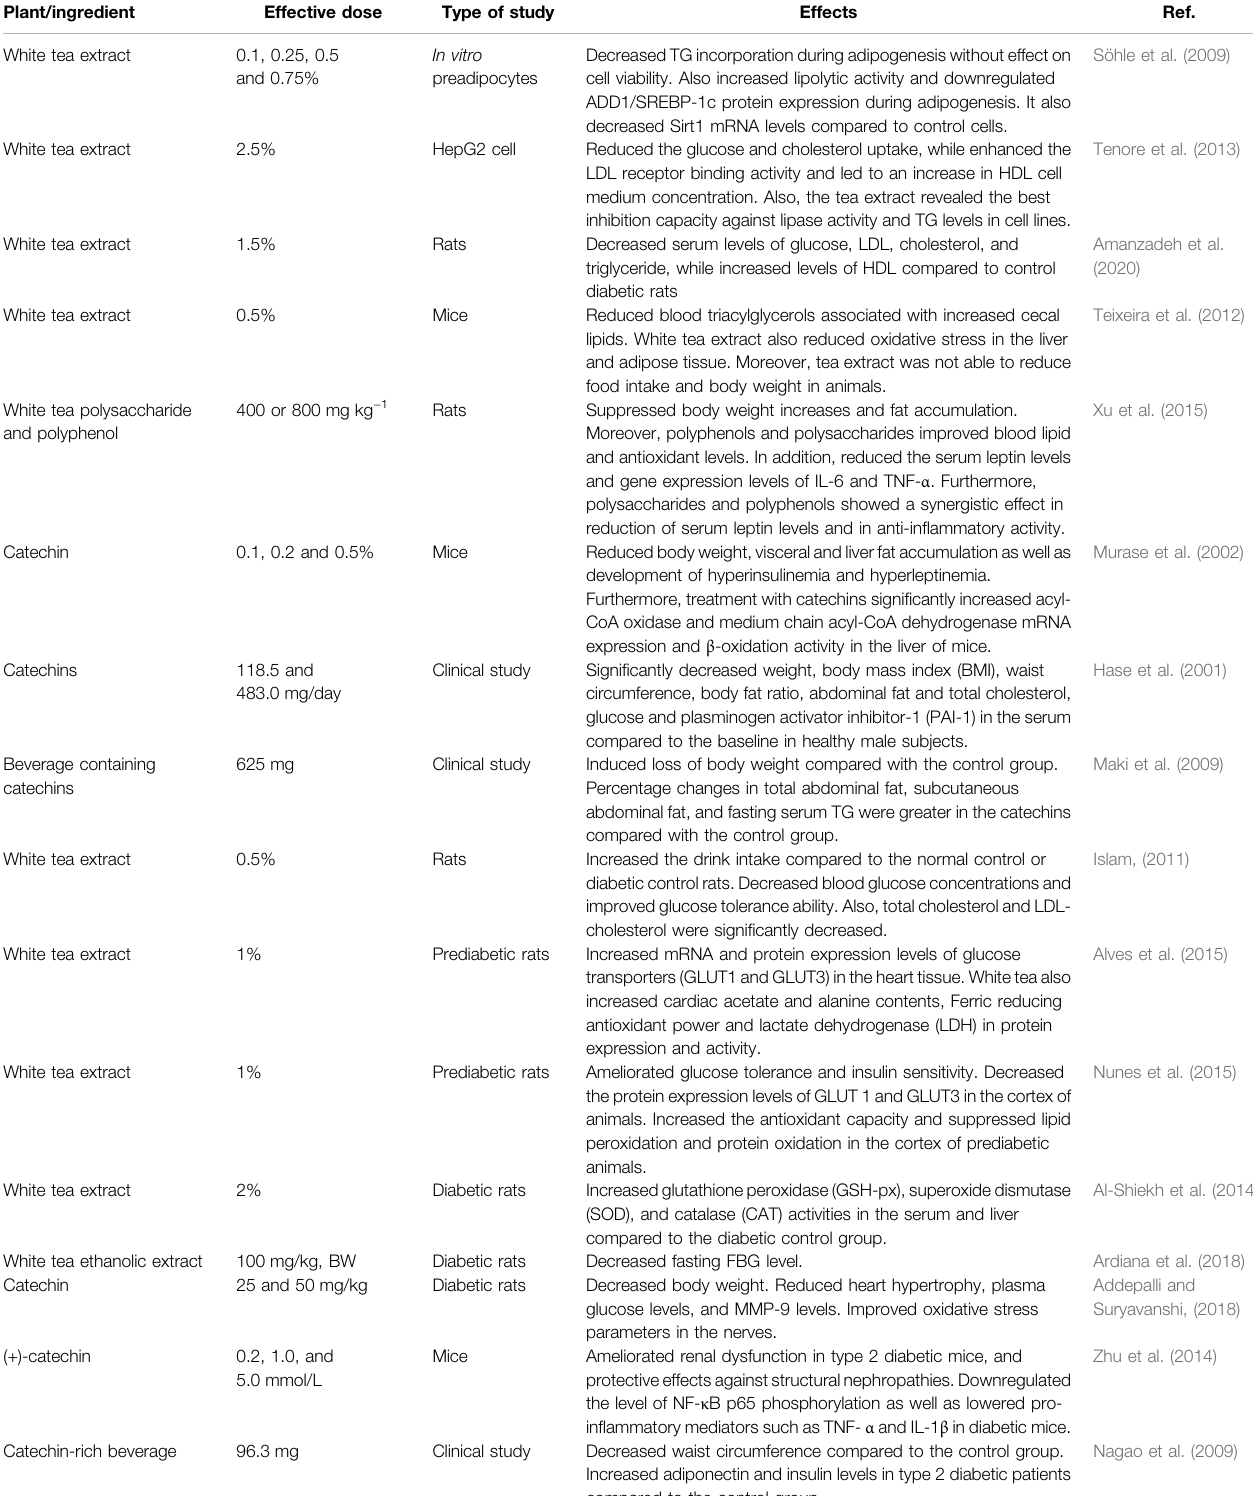
TABLE 2 | Effects of white tea and its ingredients on obesity, diabetes mellitus, and nonalcoholic fatty liver disease.